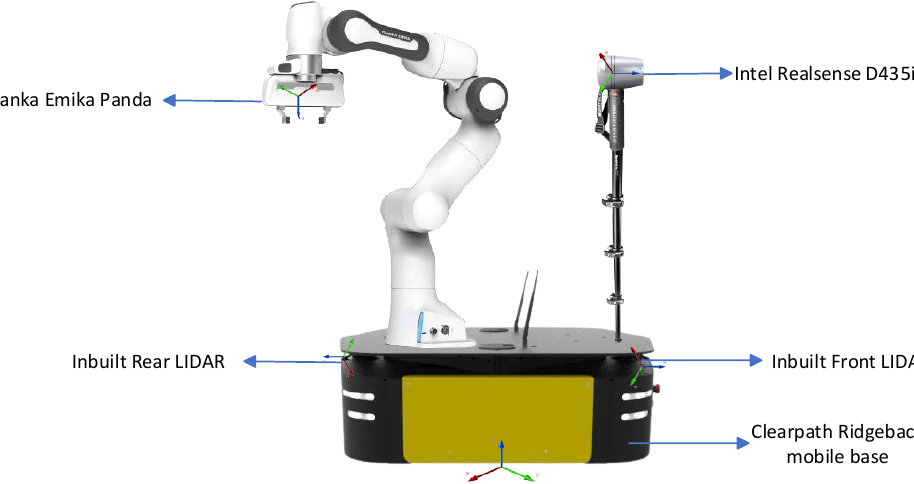
Figure 1. The hardware setup of the multi-purpose robotic system.